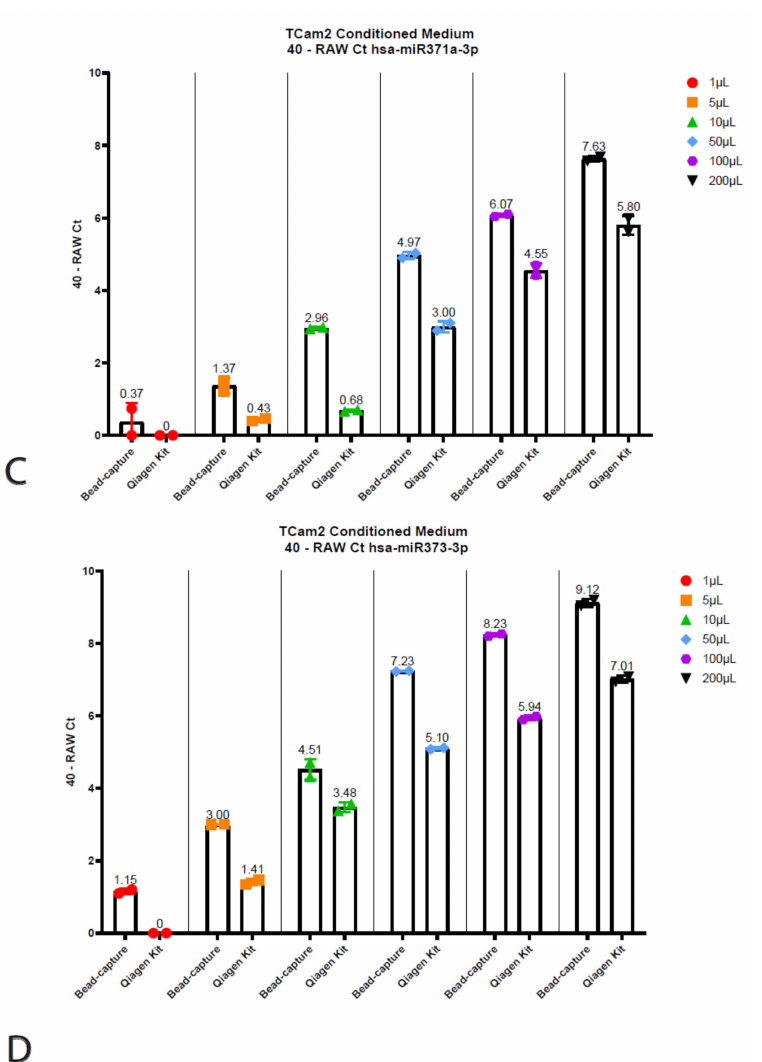
Figure 4. Titration using TCam2 conditioned medium. Displayed are the 40—Raw Ct values isolated using the bead-capture or Qiagen kit for Cel-miR39 ( A ), hsa-miR30b-5p ( B ), hsa-miR371a-3p ( C ) and hsa-miR373-3p ( D ). A 40 minus transformation was performed to improve the visual interpretation of data (high bars mean more target